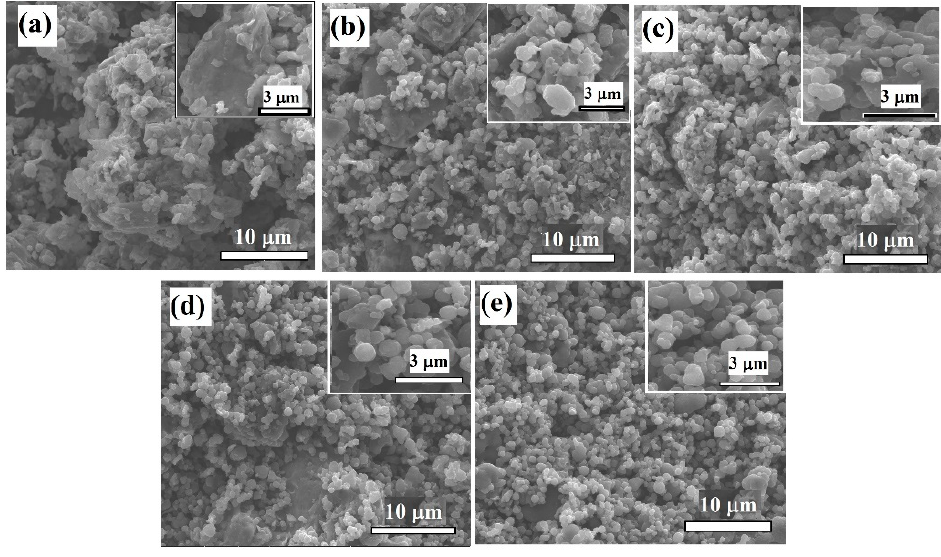
Figure 4. SEM images of TBC-0.5 ( a ), TBC-1 ( b ), TBC-2 ( c ), TBC-3 ( d ), and TC (control) ( e ).